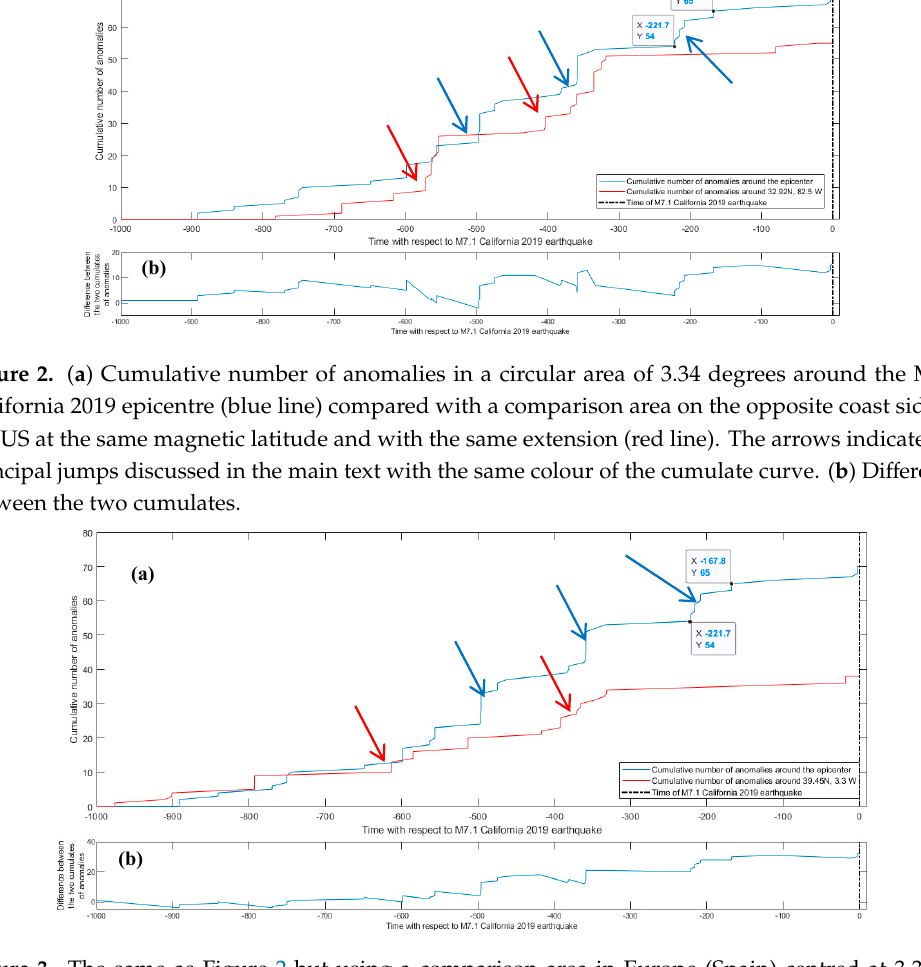
Figure 3. The same as Figure 2 but using a comparison area in Europe (Spain) centred at 3.3° W longitude and the same geomagnetic latitude of the epicentre (i.e., 39.45° N geographic latitude). ( a ) Cumulative number of anomalies; ( b ) Difference between the two cumulates.